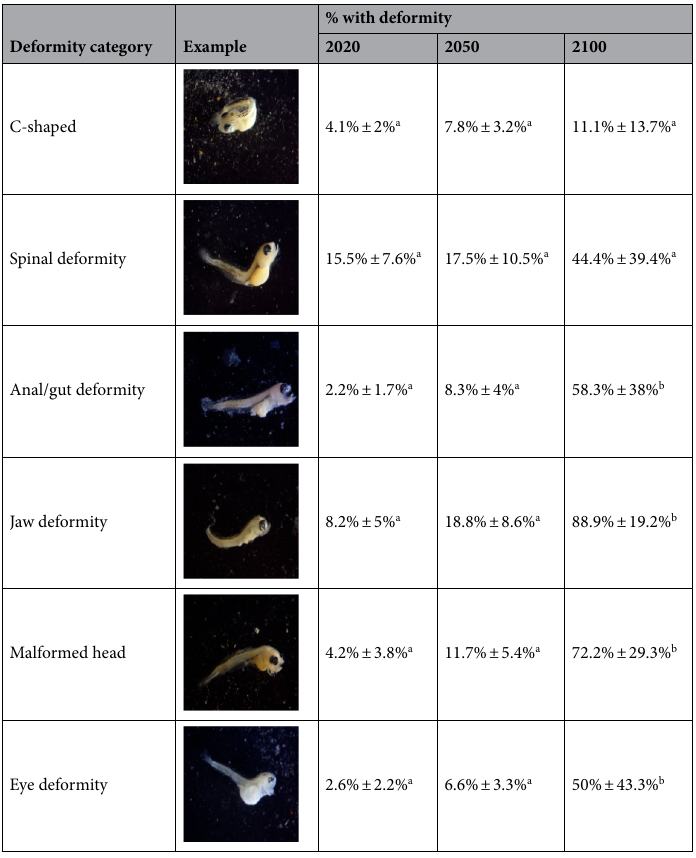
Table 3. Mean and standard deviation for the percent of larvae from each 1 g Lingcod egg mass that had a deformity in the seven deformity categories for the year 2020, year 2050, and year 2100 treatments. N represents the number of images analyzed for each treatment. GLMMs with a beta distribution were run to determine statistical significance, letters indicate significant differences (p < 0.01).